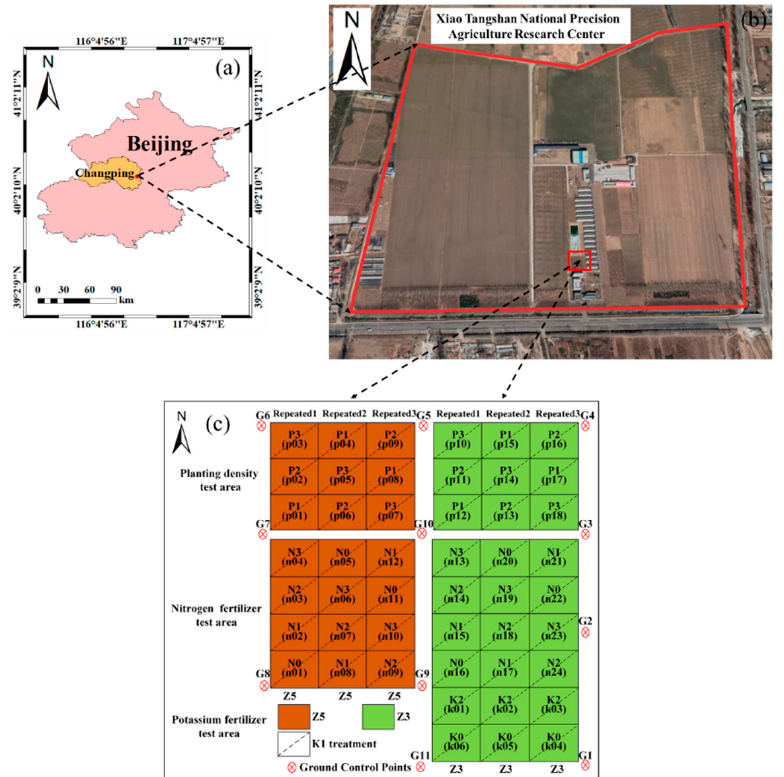
Figure 1. Location and design of experimental area: ( a ) location of Changping District in Beijing, ( b ) Xiao Tangshan National Precision Agriculture Research Center, ( c ) P1, P2, and P3 represent planting density treatments of 60,000, 72,000, and 84,000 plants/hm 2 , respectively. N0, N1, N2, and N3 represent nitrogen fertilization treatments of 0, 244.65, 489.15, and 733.50 kg/hm 2 , respectively. K0, K1, and K2 represent potassium fertilization treatments of 0, 970.50, and 1941 kg/hm 2 , respectively.